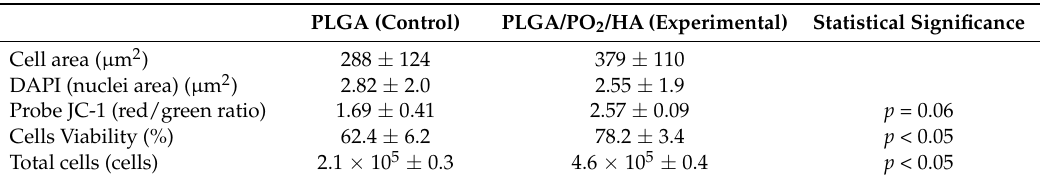
Table 2. Studied variables in vitro cell cultures.